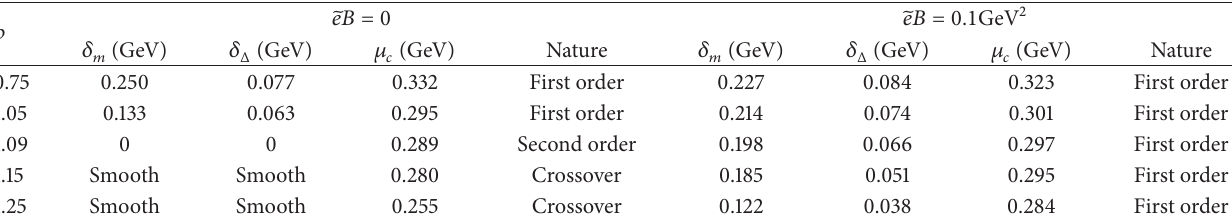
( ∼ 5 × 10 18 G) for various values of 𝜌 = 𝐺 𝐷 /𝐺 𝑆 . The nature of the transition is also indicated.